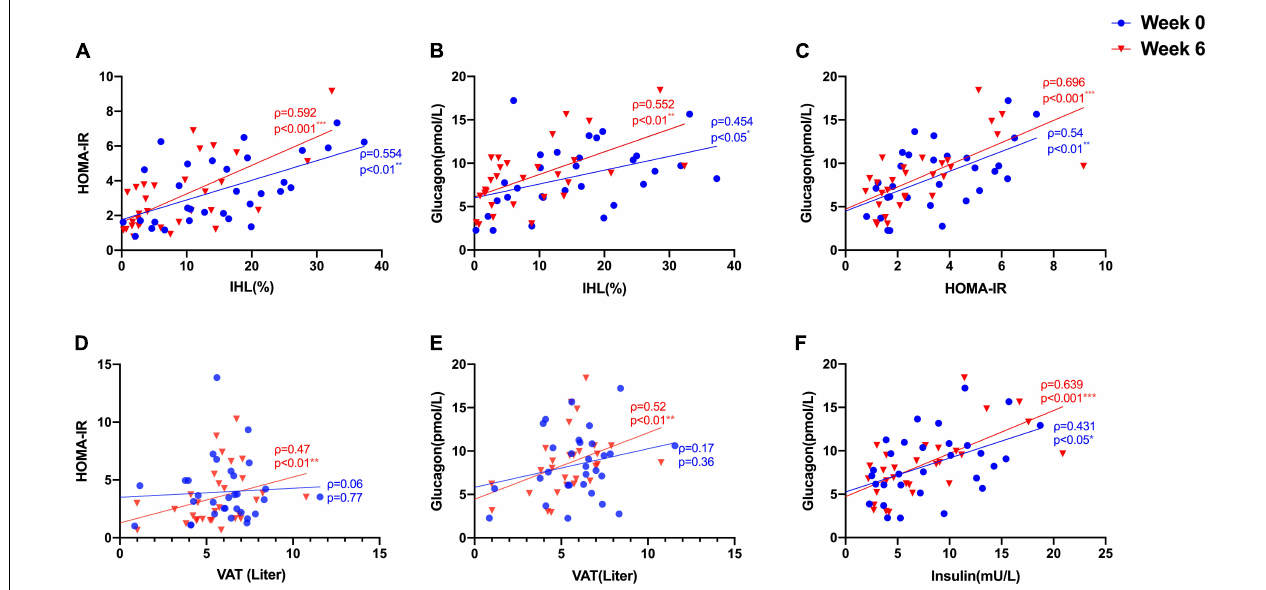
FIGURE 1 | Correlations between (A) IHL (%) and insulin sensitivity (HOMA-IR); (B) IHL (%) and GCGN; (C) HOMA-IR and GCGN; (D) visceral adipose tissue (VAT) and HOMA-IR; (E) VAT and GCGN; (F) correlations between fasting insulin and GCGN before (Week 0, blue) and after high protein intake intervention in the entire study group (Week 6, red). * p < 0.05; ** p < 0.01; *** p <